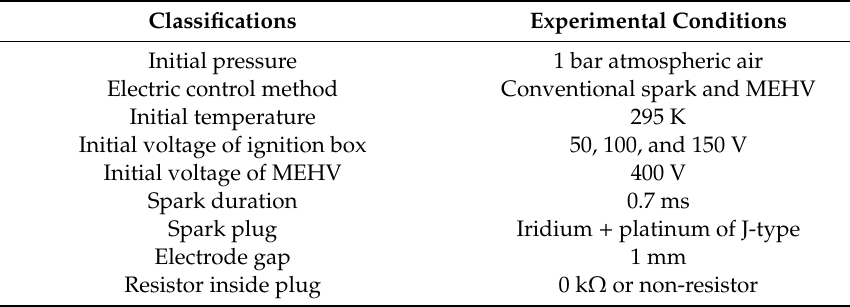
Table 5. Experimental